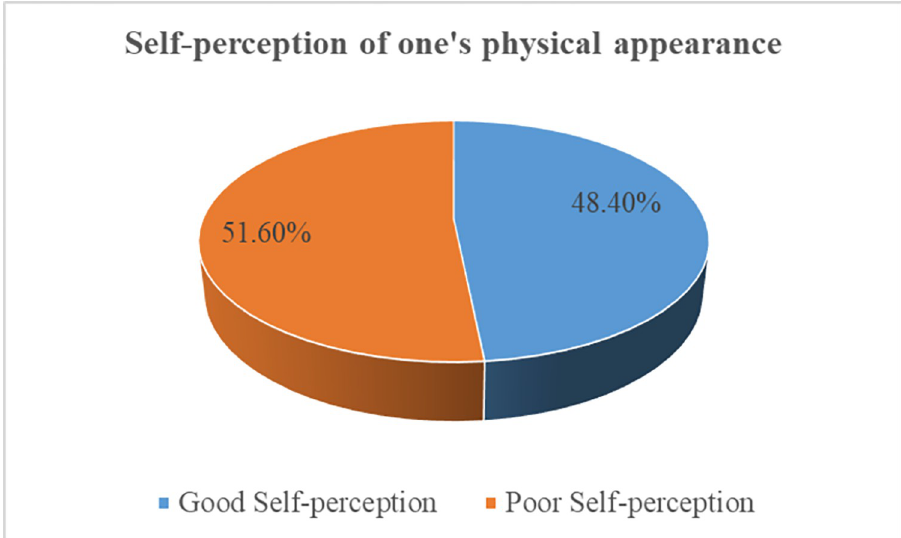
Fig 1. The level of self-perception of one’s physical appearance of adolescents in Addis Ababa city, Ethiopia.